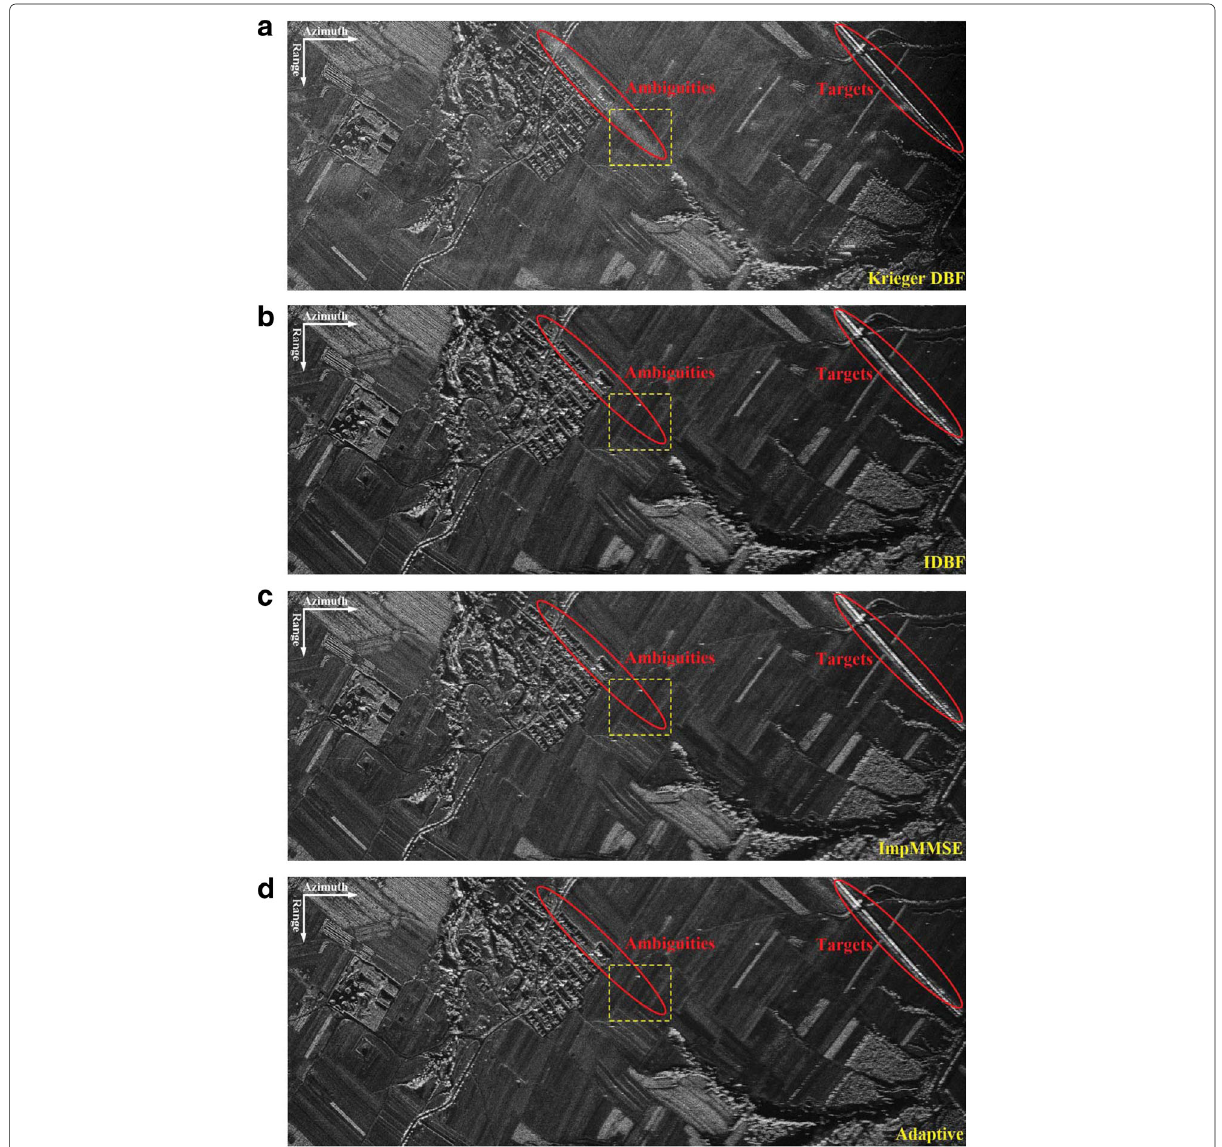
Fig. 13 SAR images using the results reconstructed by different algorithm. a Krieger DBF method. b The IDBF method. c The ImpMMSE method. d Our proposed